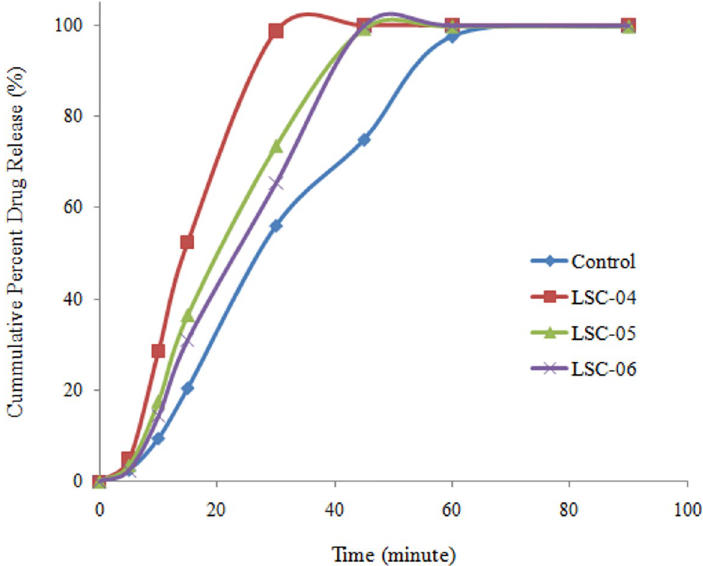
Fig 6. Drug release from liquisolid compacts containing different concentrations of starch.